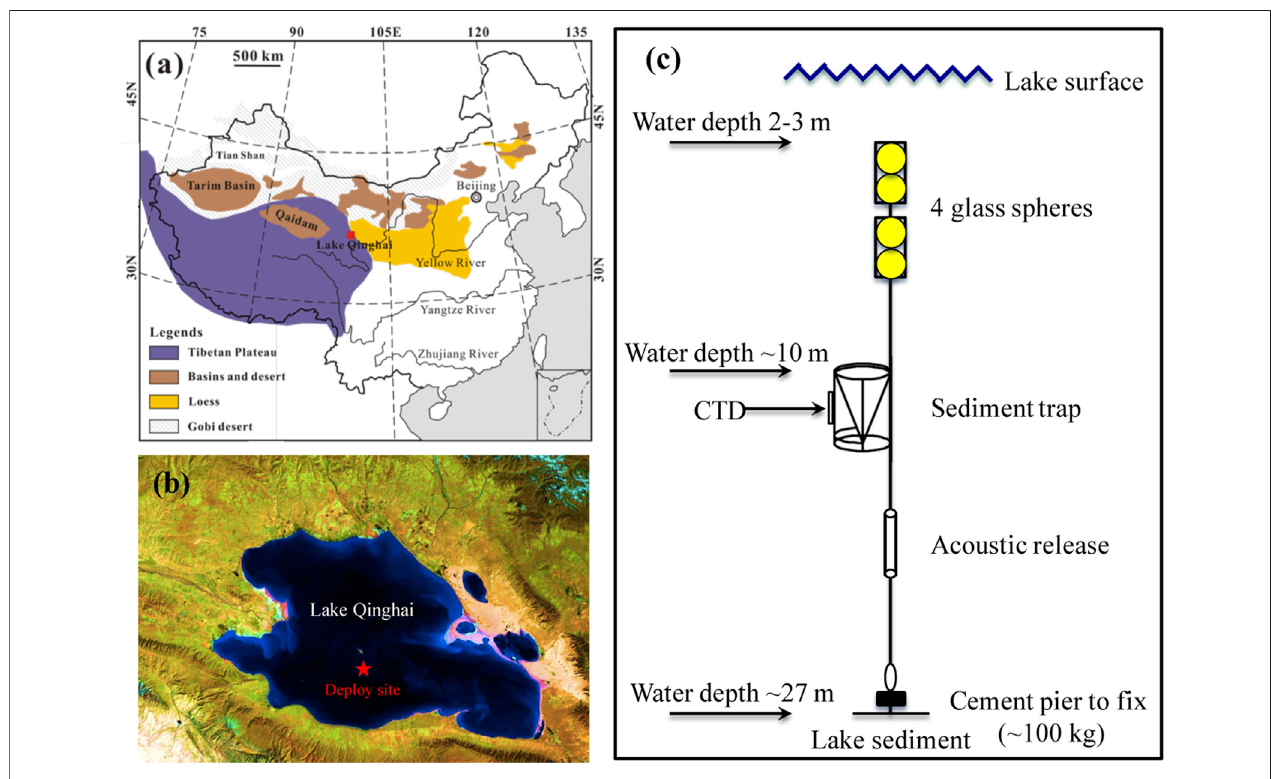
FIGURE 1 | (A) Sketch map showing the location of Lake Qinghai (red square) and the surrounding region, including the Tibetan Plateau, the Chinese Loess Plateau, the Qaidam and Tarim Basins, and the Gobi desert. (B) The deployed (red solid star) site of the Mark 8 – 13 time-series sediment trap in Lake Qinghai. (C) Underwater mooring design of Mark 8 – 13 sediment trap in Lake